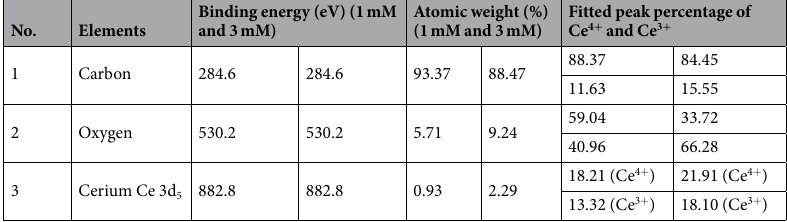
Table 2. Atomic weight percent of the elements with binding energy values.